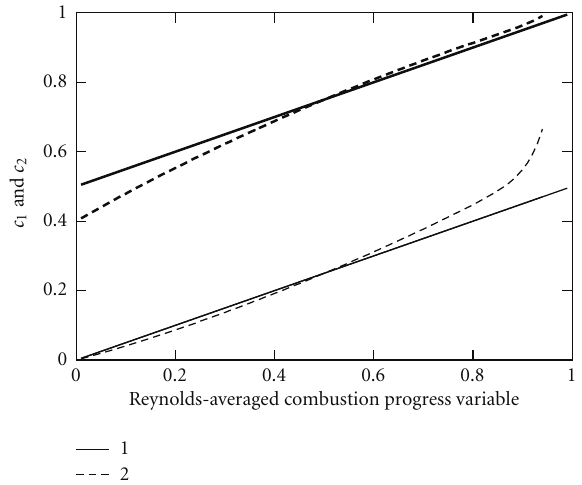
Figure 7: Dependencies of the parameters c 1 (thin curves) and c 2 (bold curves) on the Reynolds-averaged combustion progress variable, calculated for F = 1 . 0 and g = 0 . 5 using the R-2 δ -PDF (curves 1) and the 2 δ -PDF (curves 2).